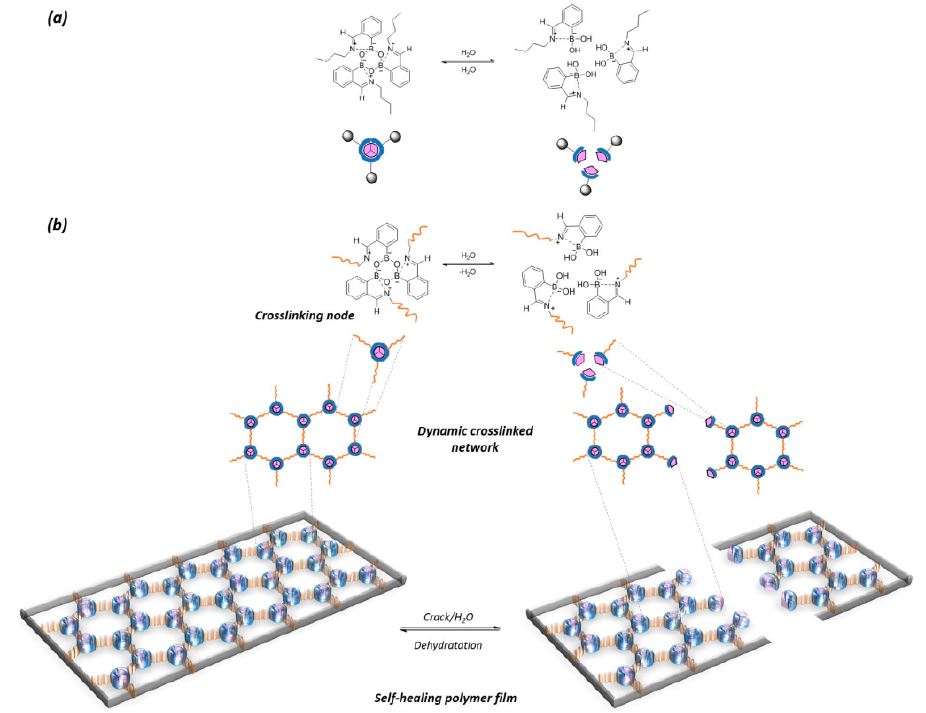
Figure 7. Equilibrium formation of the boroxine ring ( a ) and formation of self-healing films due to dynamically formed boroxine rings ( b ) Reprinted with permission from [8479]. Copyright 1999–2022 John Wiley & Sons, Inc.